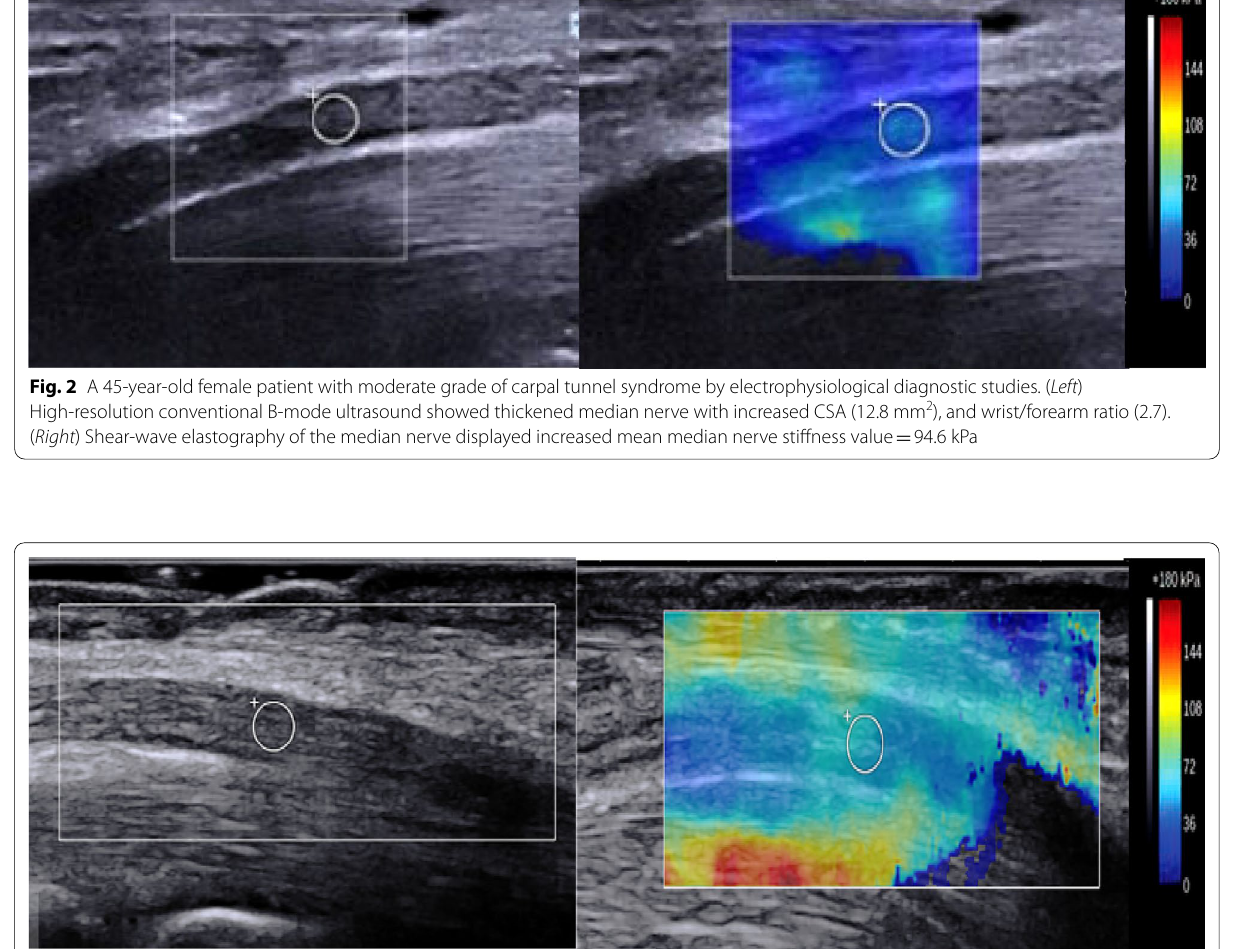
Fig. 3 A 58-year-old male patient with severe grade of carpal tunnel syndrome by electrophysiological diagnostic studies. ( Left ) High-resolution conventional B-mode ultrasound showed thickened median nerve with increased CSA (13.6 mm 2 ) and calculated wrist/forearm ratio (2.9). ( Right ) Shear-wave elastography of the median nerve displayed increased mean median nerve stiffness value